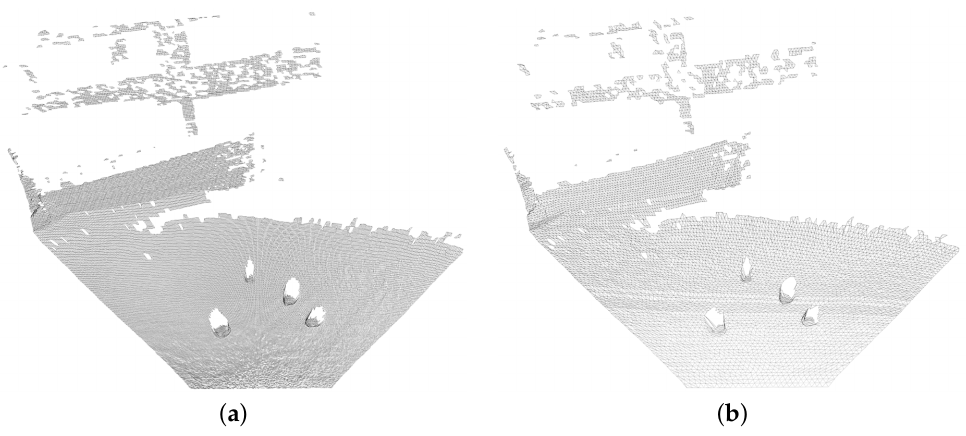
Figure 18. Full resolution mesh with 116,000 triangles ( a ) and simplified mesh ( δ = 0.1 m) with 13,700 triangles ( b ).